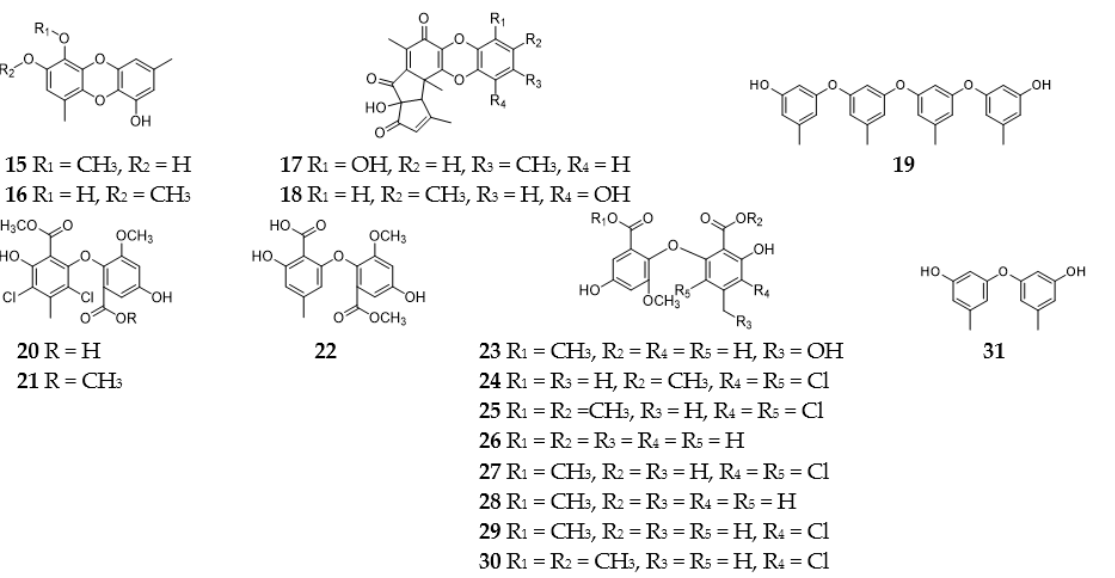
Figure 4. Aspergillus -derived furanones ( 44 – 76 ).